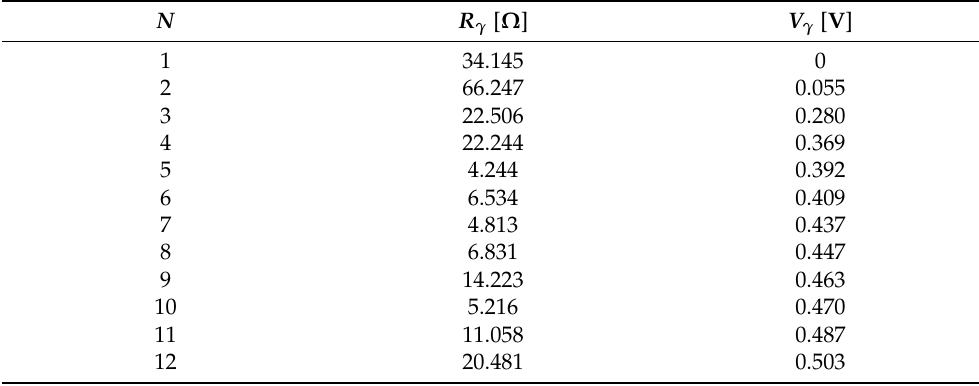
Figure 9. P-V curves using the 1M5P model and the proposed model, at T = 40 ◦ C. At 50 ◦ C, the 1M5P parameters are I L = 0.243 A, I o = 7.576 × 10 − 21 A, n = 0.423, R sh = 34.696 Ω and R s = 0.422 Ω , and the curves are illustrated in Figure 10. This figure also includes the experimental data and the d1M5xP curve (in this case x = 24). The parameters of d1MxP are in Table 3 and the P-V comparative curves are shown in Figure 11. Table 3. Quantitative values computed for the branches connected in parallel, for T = 50 ◦